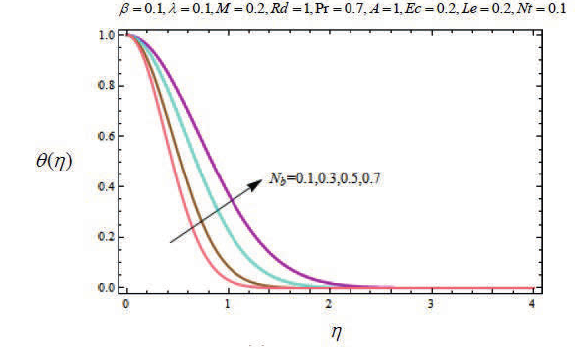
Fig. 9: Variation of temperature profile θ ( η ) with η for several values of Brownian motion parameter N b .